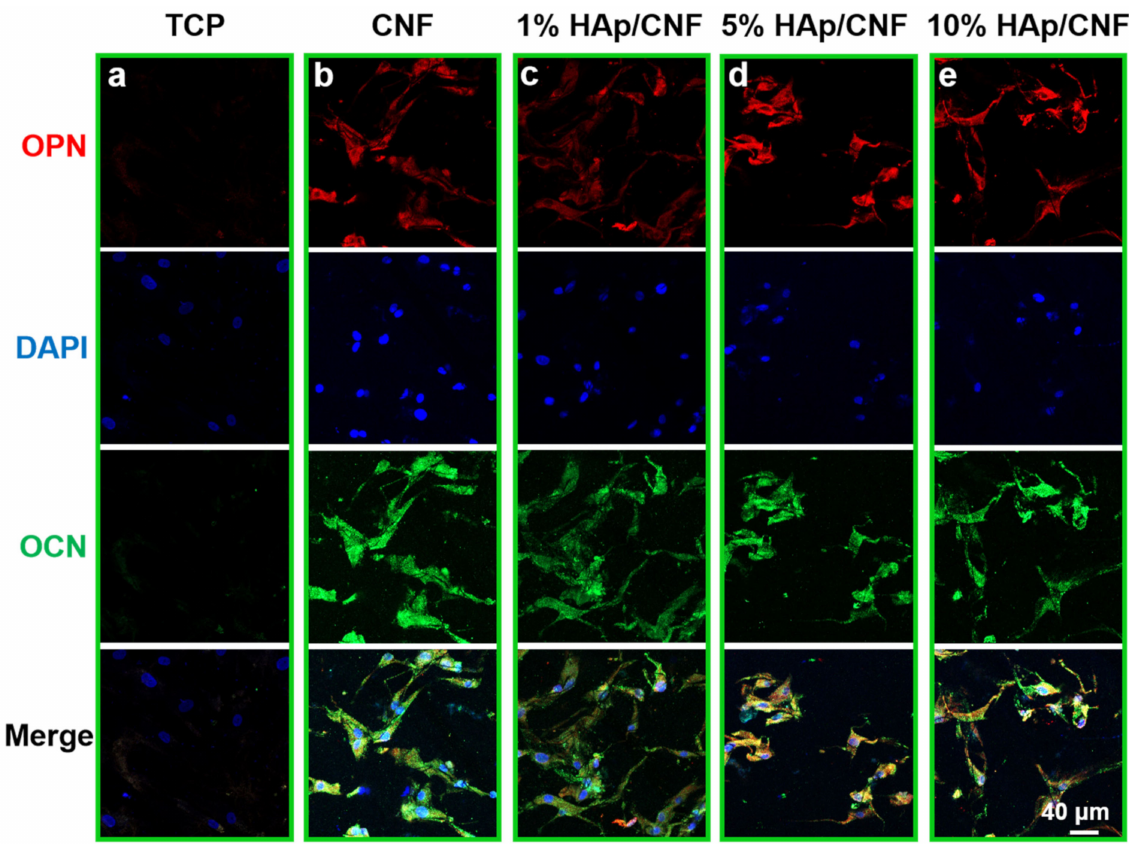
Figure 5. Immunofluorescent detection of proteins indicative of osteogenic differentiation in h- ADSCs cultured on different materials. Cells grown on ( a ) tissue culture plastic (TCP), ( b ) CNF, ( c ) 1% HAp/CNF, ( d ) 5% HAp/CNF, or ( e ) 10% HAp/CNF were fixed and stained with antibodies to the noted proteins. Red represents osteopontin (OPN), green represents osteocalcin (OCN), and blue represents